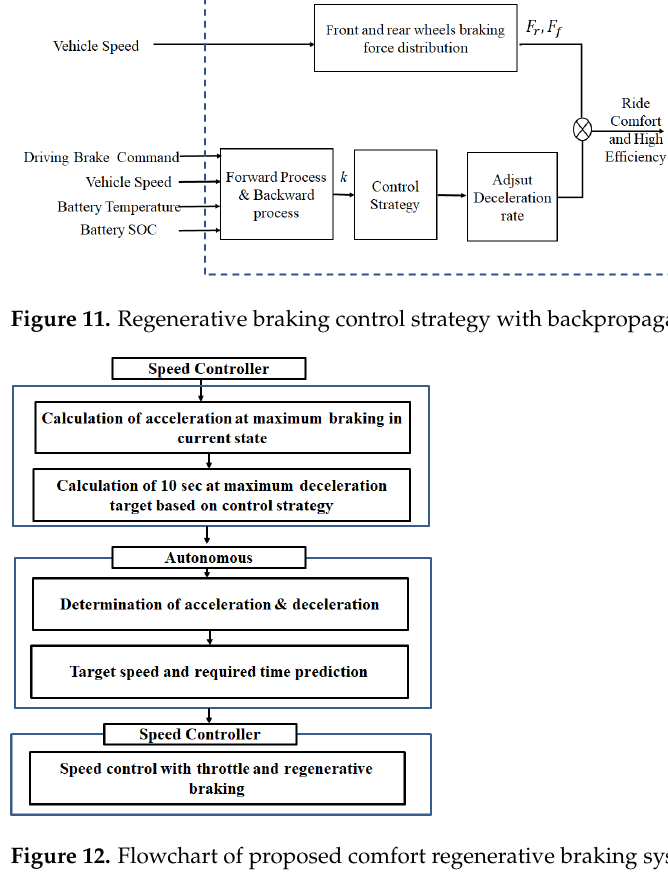
Figure 12. Flowchart of proposed comfort regenerative braking system